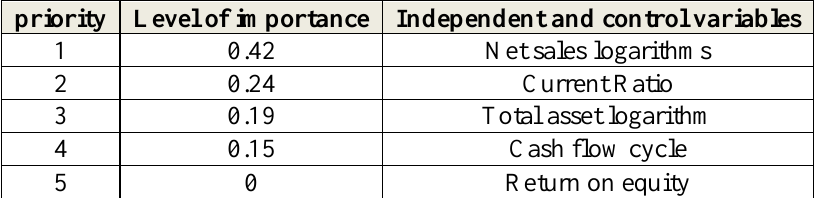
Table 14. How to enter variables into backup vector machine